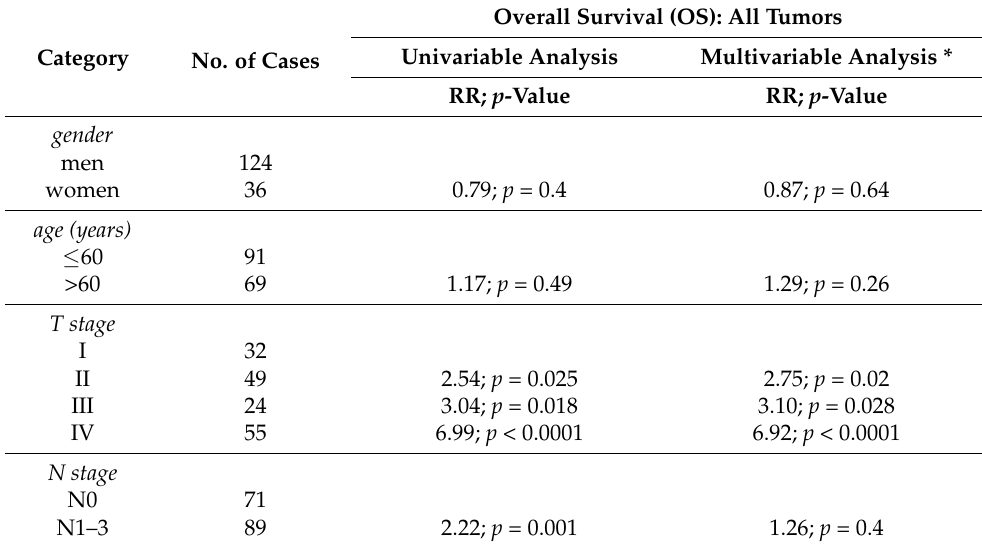
Table 1. Clinicopathologic Data and Overall Survival of 160 HPV − OSCC